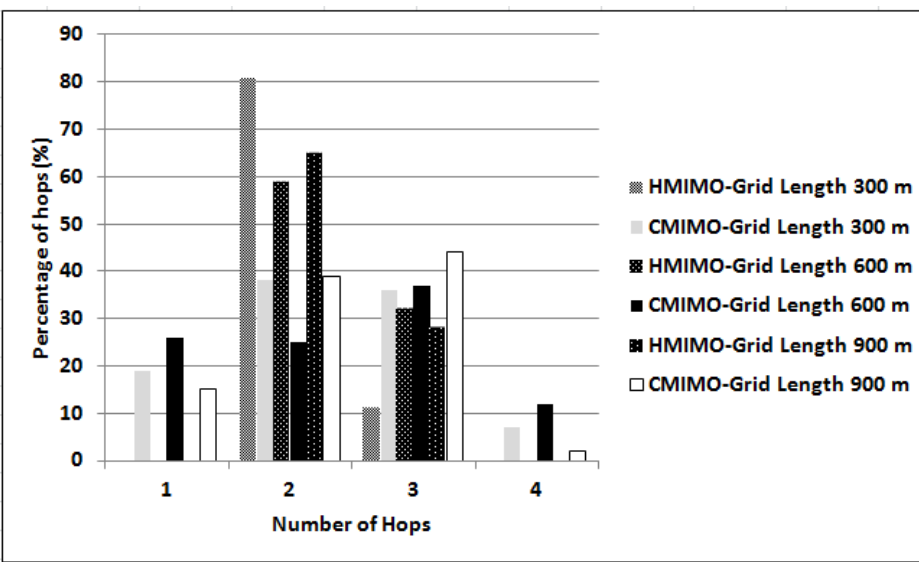
Figure 10. Histogram of number of hops to Central Coordination